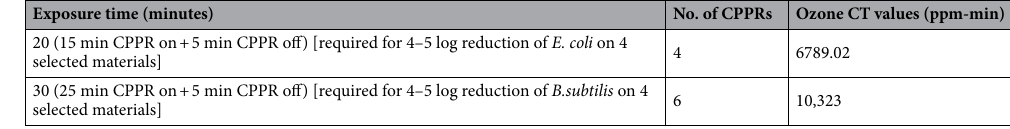
Table 2. Ozone CT (concentration x time) values in APS for the number of CPPRs and exposure times.